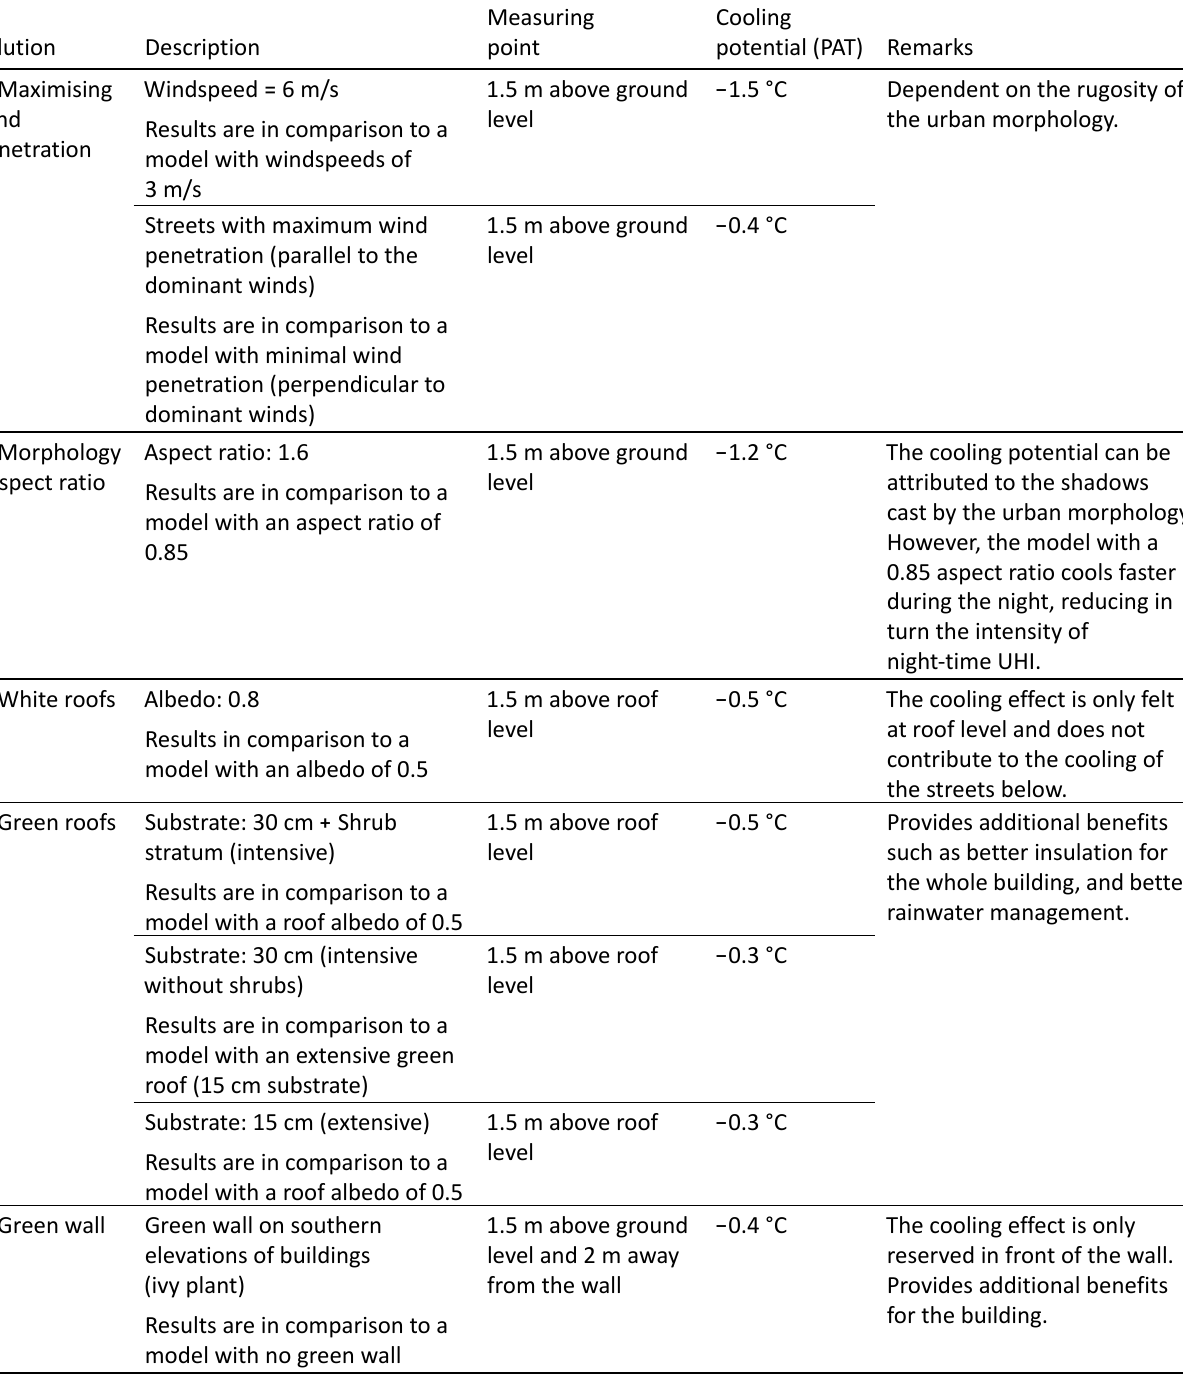
Table 1. (Cont.) Results of the hierarchisation of the cooling effect (PAT) of all simulated solutions on